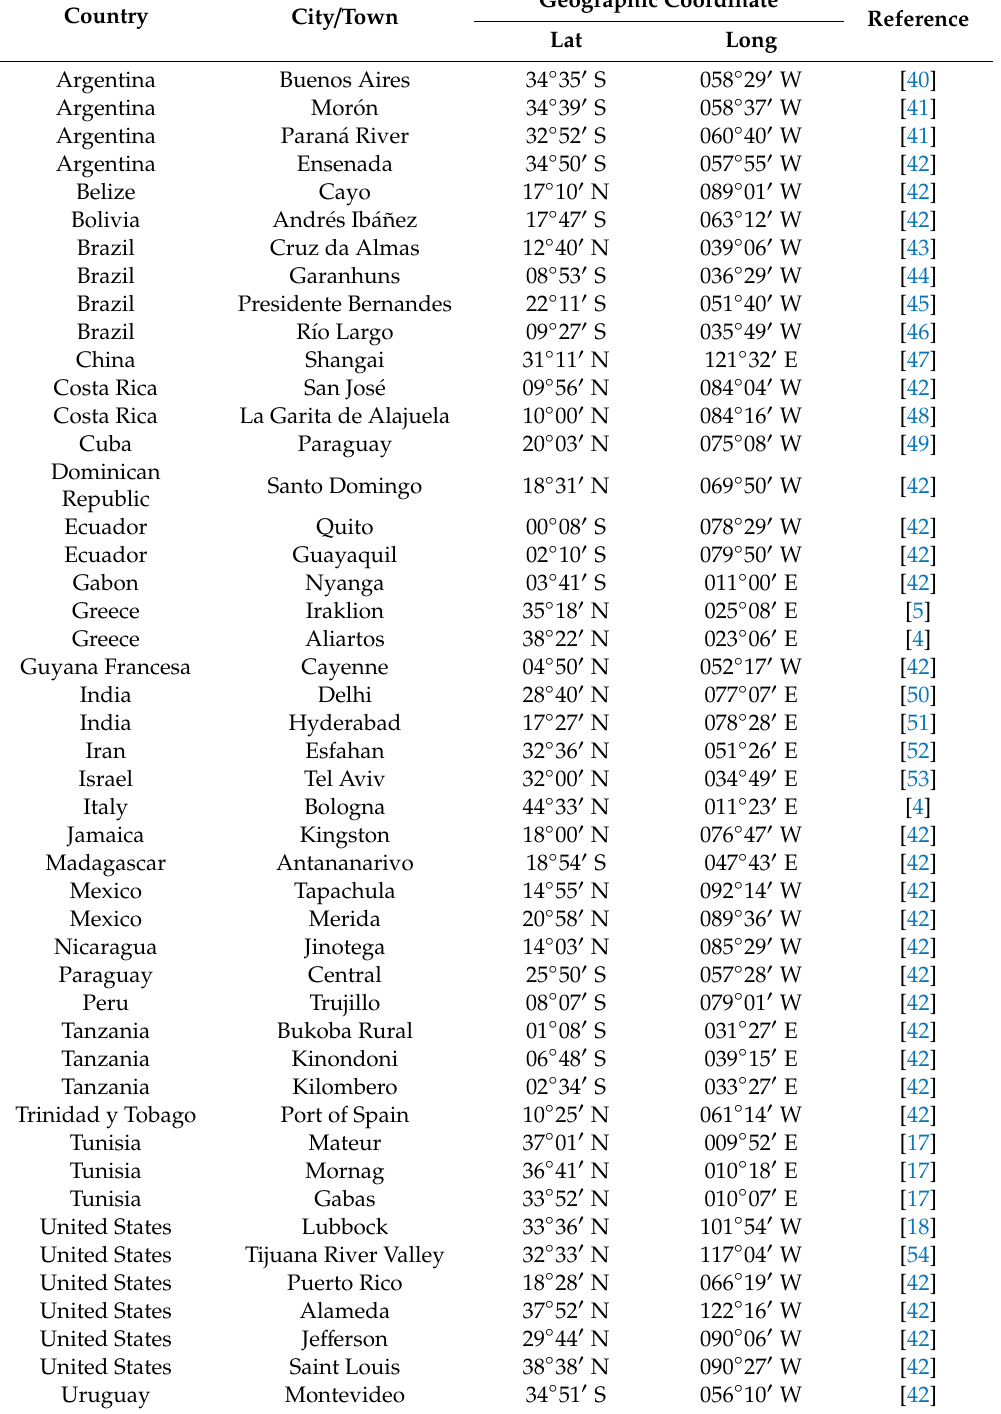
Table A1. Cities or towns in which castor bean has been registered; these were used to determine climate requirements for its